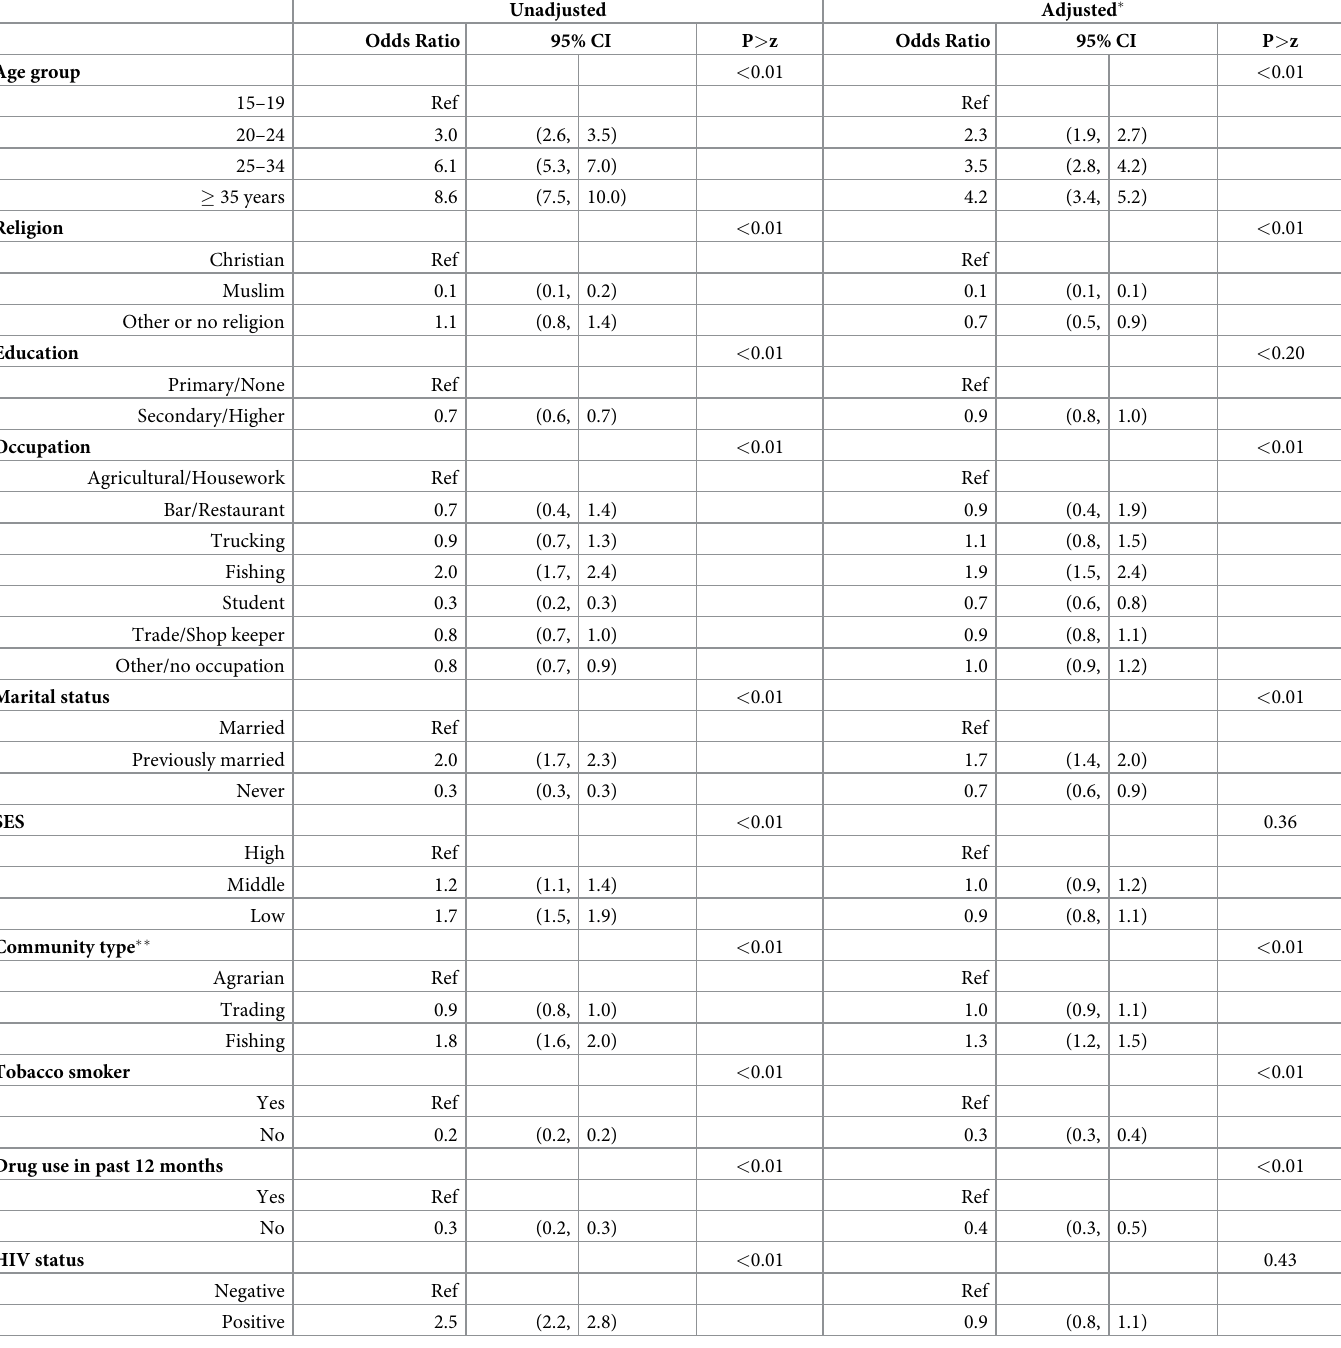
Table 3. Unadjusted and adjusted logistic regression models of correlates of alcohol use in the past 12 months in all men (N = 8,690) who participated in RCCS between March 2015 and September